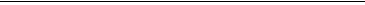
Figure 1 . Feynman diagrams for (a) CF and (b) DCS D 0 !